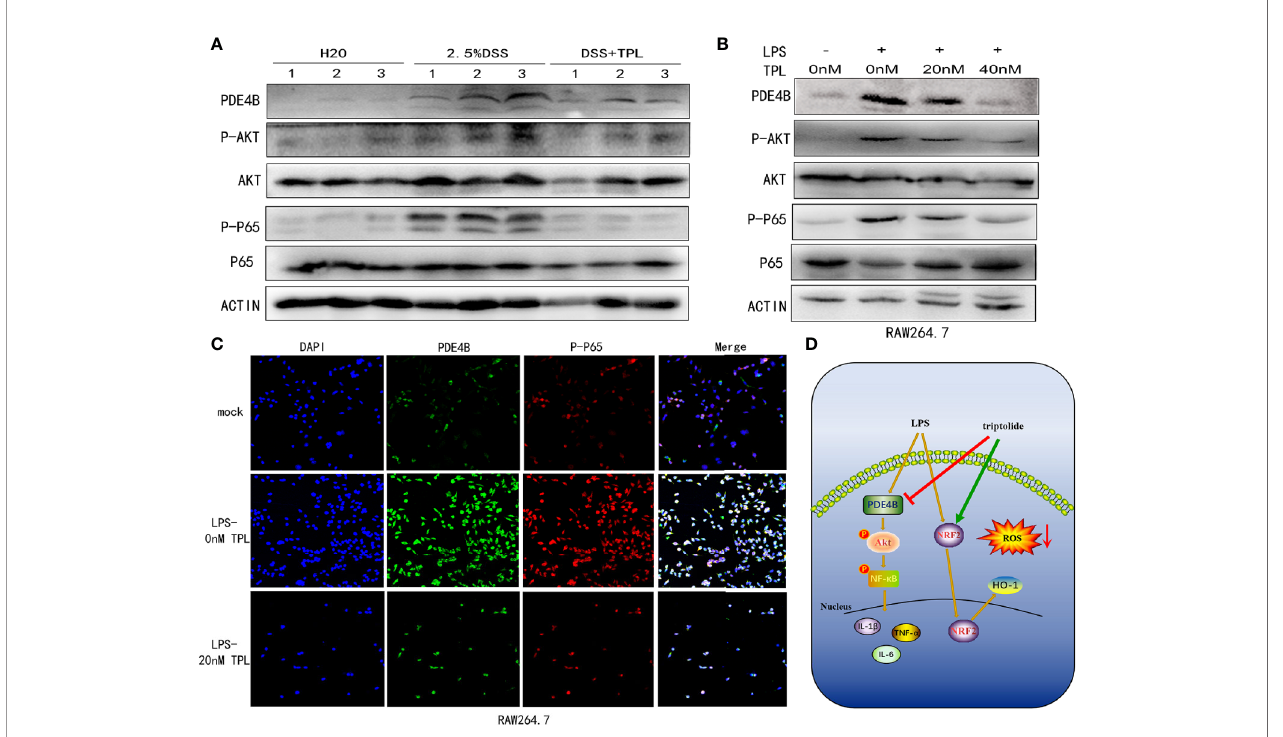
FIGURE 7 | Triptolide treatment alleviated DSS-induced intestinal in fl ammation through the PDE4B/AKT/NF- k B axis in vivo and in vitro . Mice aged 6 – 8 weeks were treated with 2.5% DSS with or without triptolide administration. (A) Western blots were used to measure the protein levels of PDE4B, total AKT, phosphorylated AKT, total P65, and phosphorylated P65 in colitis tissue. RAW 264.7 macrophages were treated with 1000 ng/ml LPS plus 0 – 40 nM triptolide for 24 h. (B) Western blots were used to measure the protein levels of PDE4B, total AKT, phosphorylated AKT, total P65, and phosphorylated P65 in RAW 264.7 macrophages. (C) Immuno fl uorescence assays were performed to determine PDE4B and phosphorylated P65 levels. (D) The fl owchart of triptolide in the DSS-induced colitis model. Data are shown as the mean ± SD of at least three independent fi ndings imply that PDE4B is a promising target in IBD since PDE4B activity is closely related to M1 type macrophage in fi ltration.